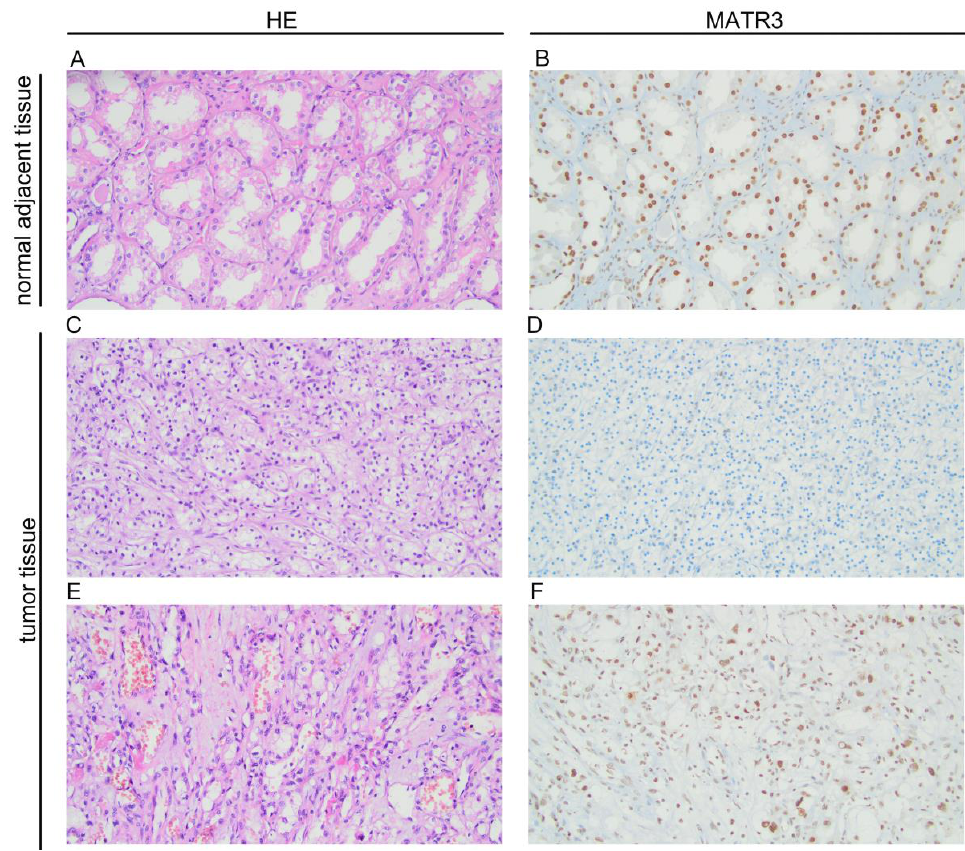
Figure 1. Representative pictures of hematoxylin and eosin staining and immunohistochem- ical expression of MATR3 in clear cell renal cell carcinoma (ccRCC) and adjacent normal tis- sues. ( A ) hematoxylin-eosin (HE) staining in adjacent tissue; ( B ) MATR3 staining in adjacent tis- sue; ( C ) hematoxylin-eosin (HE) staining in ccRCC; ( D ) negative staining for MATR3 in ccRCC; ( E ) hematoxylin-eosin (HE) staining in ccRCC; ( F ) positive staining for MATR3 in ccRCC (primary magnification × 20). Figure prepared using Adobe Photoshop